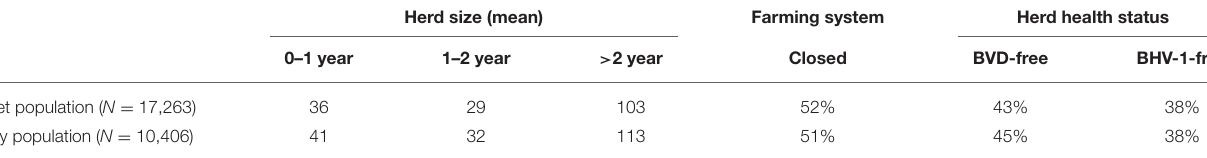
TABLE 2 | Characteristics of dairy herds in the slaughterhouse dataset (study population) and all dairy herds in the Netherlands (target population) between January 2015 and September 2018.